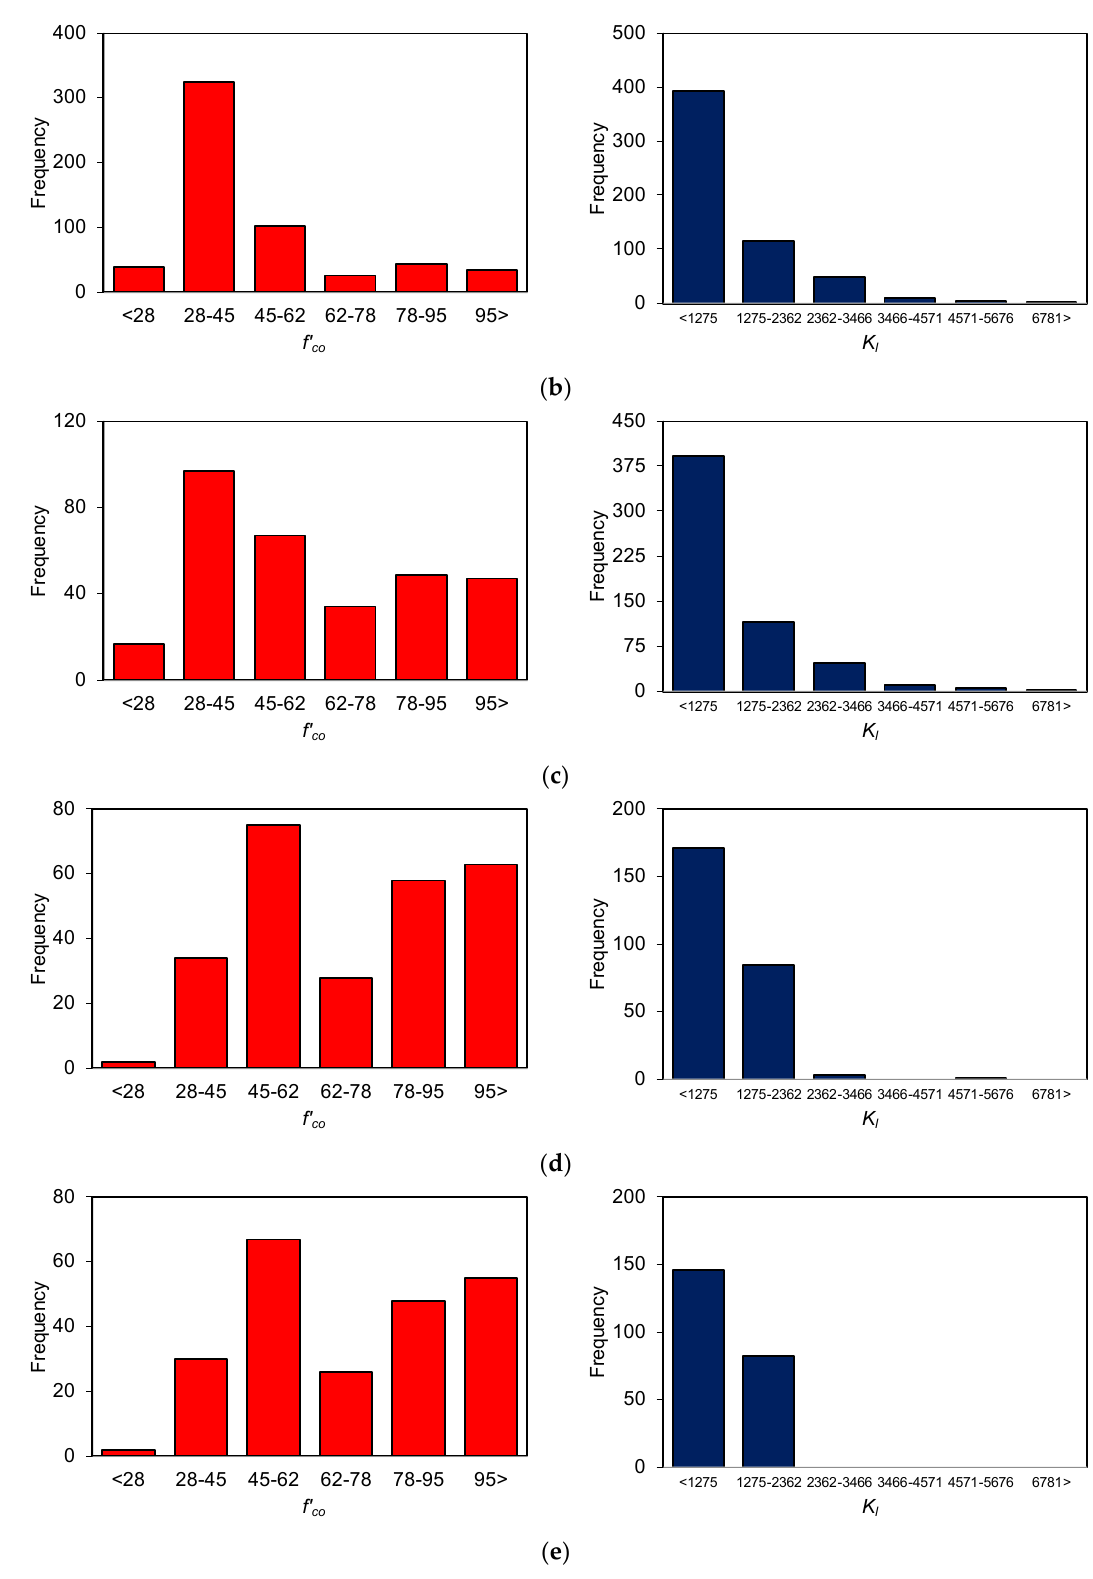
Figure 1. Frequency distribution of f’ co and K l in prepared database for: ( a ) f’ cc , ( b ) ɛ cu , ( c ) ɛ h,rup , ( d ) f’ c1 , and ( e ) ɛ c1 .